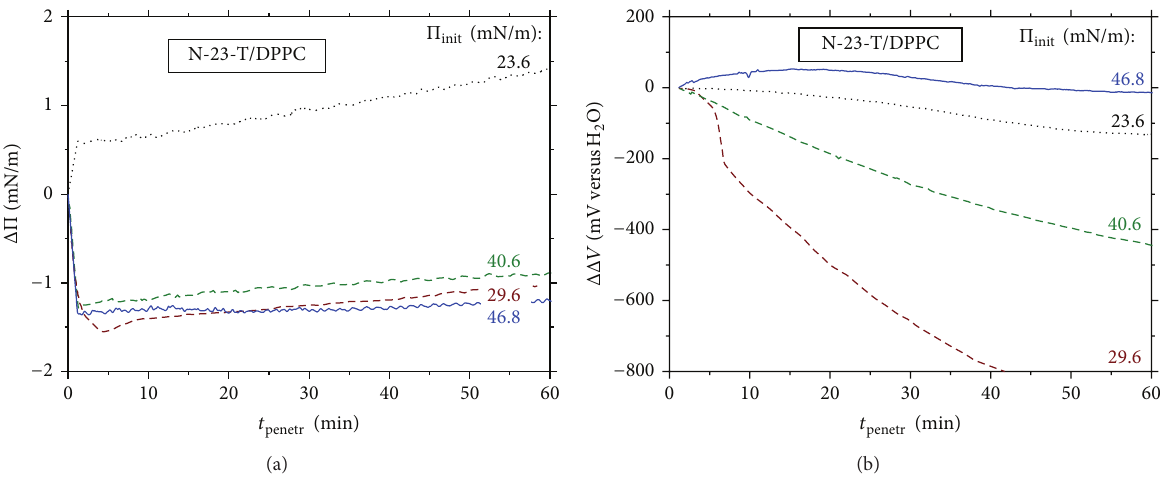
Figure 4: Time evolution of the effects on (a) surface pressure ( ΔΠ ) and (b) electric surface potential ( ΔΔ𝑉 ) caused by penetration of lactophoricin-I (N-23-T) to DPPC monolayer under stationary diffusion conditions; the courses registered at various initial densities of (denoted therein). The peptide’s concentration is 1 𝜇 M. pure DPPC monolayer are characterized by the initial surface pressure values, Π init